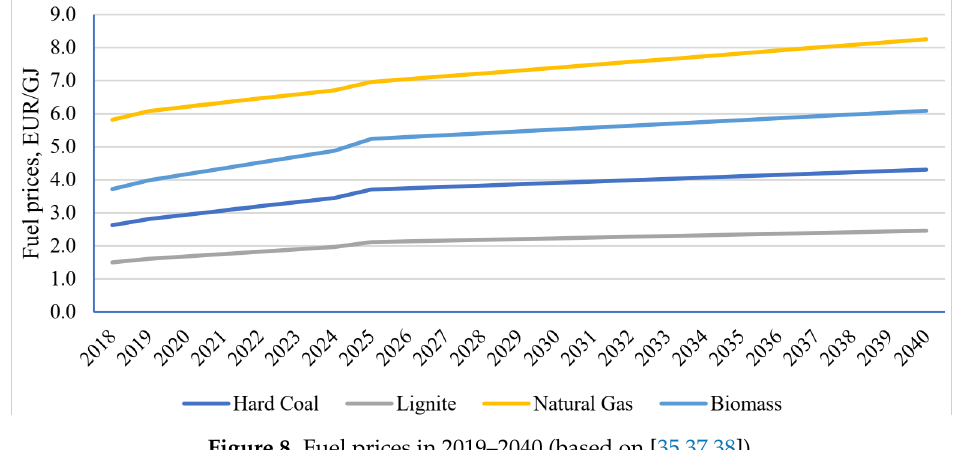
Figure 8. Fuel prices in 2019–2040 (based on